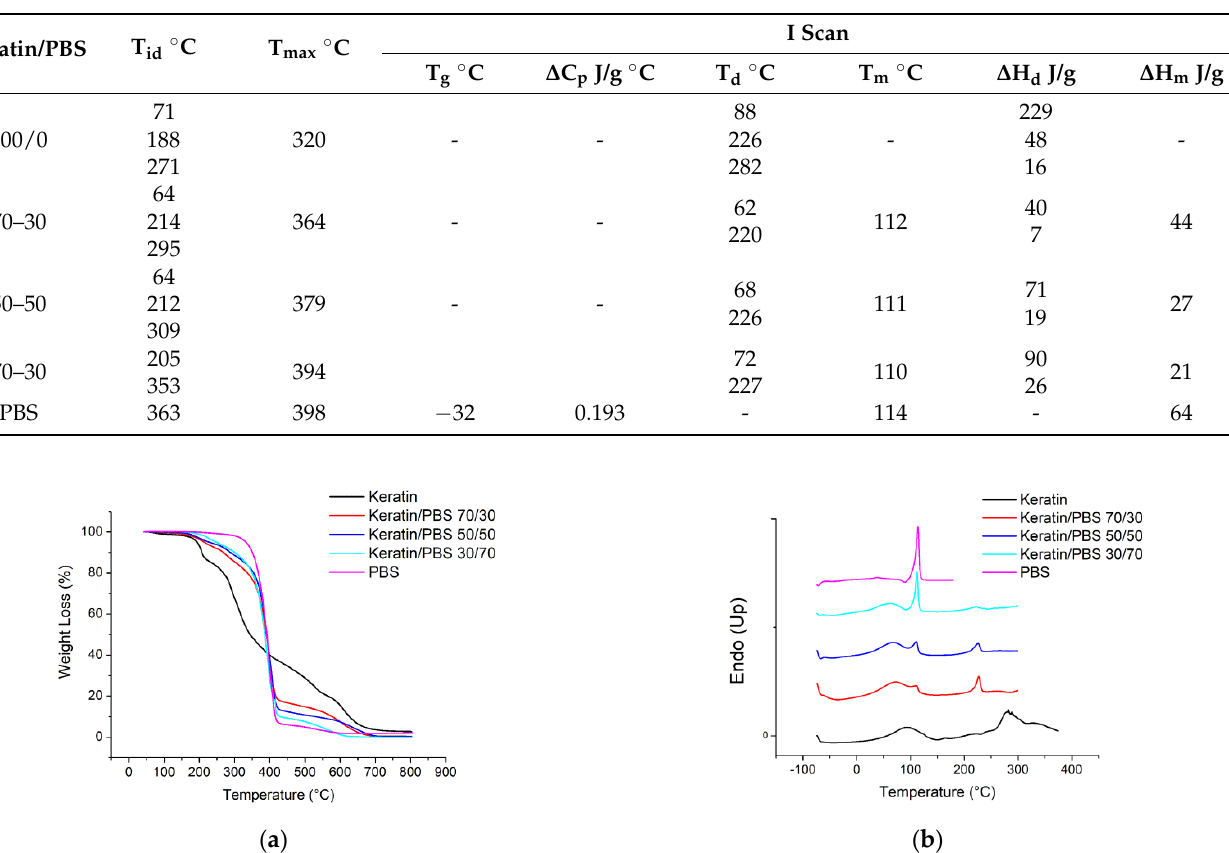
Figure 5. ( a ) TGA and ( b ) I scan DSC curves of PBS, Keratin and Keratin/PBS blend electrospun mats. Table 3. Thermal characterization data (TGA and DSC) of PBS, keratin and Keratin/PBS blend elec- trospun mats.